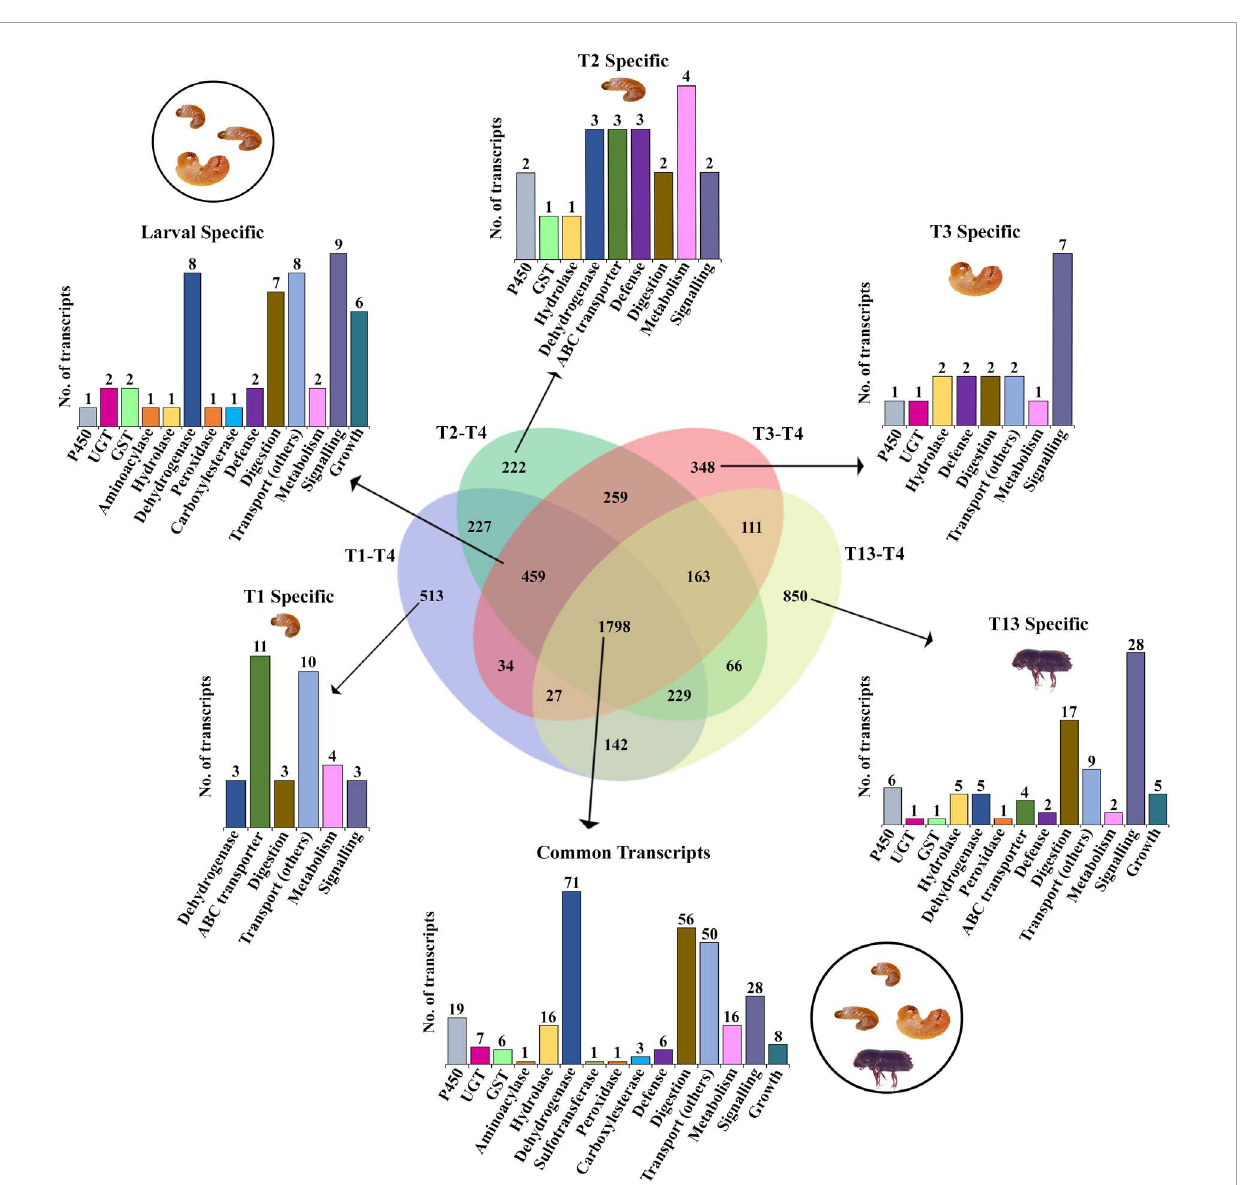
FIGURE5 Venn diagram representation of feeding vs. non-feeding stage comparison for upregulated enzymes using FDR p < 0.05 and fold change ≥ 2 as the threshold for significance. Numbers within the Venn diagram represent the number of contigs found for each group. The bar graph corresponds to the number of contigs of each gene family identified from the list ( Supplementary material 36